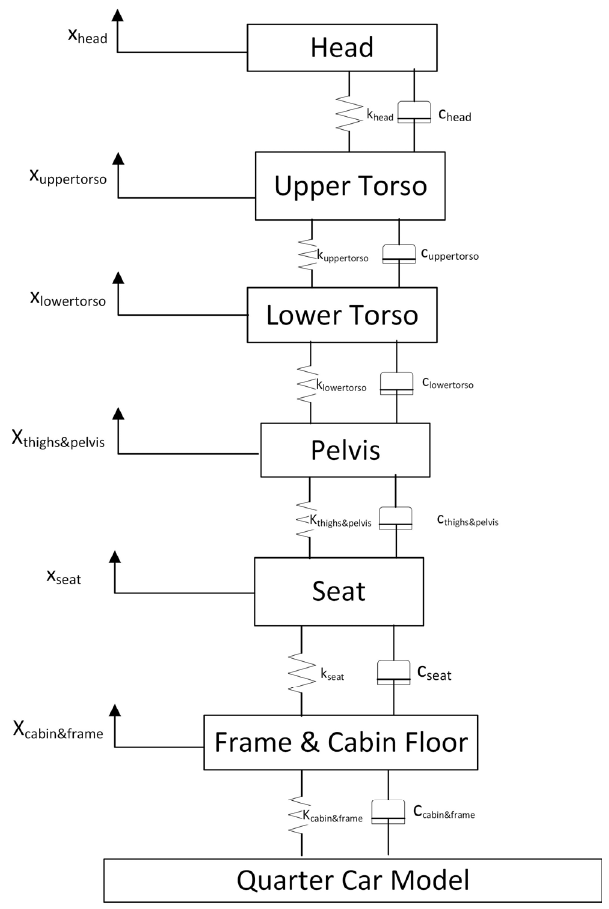
Figure 4. The eight DOFs VSH model. The human body was modeled using the four DOFs lumped parameter human model suggested by Boileau and Rakheja [19]. This models consisted of the head and neck mass ( m head = 5.31 kg), the chest and upper torso mass ( m uppertorso = 28.49 kg), the lower torso mass ( m lowertorso = 8.62 kg) and the thigh and pelvis mass ( m thighs & pelvis = 12.78 kg). These masses were interconnected with stiffness and damping elements with values that are presented in Table